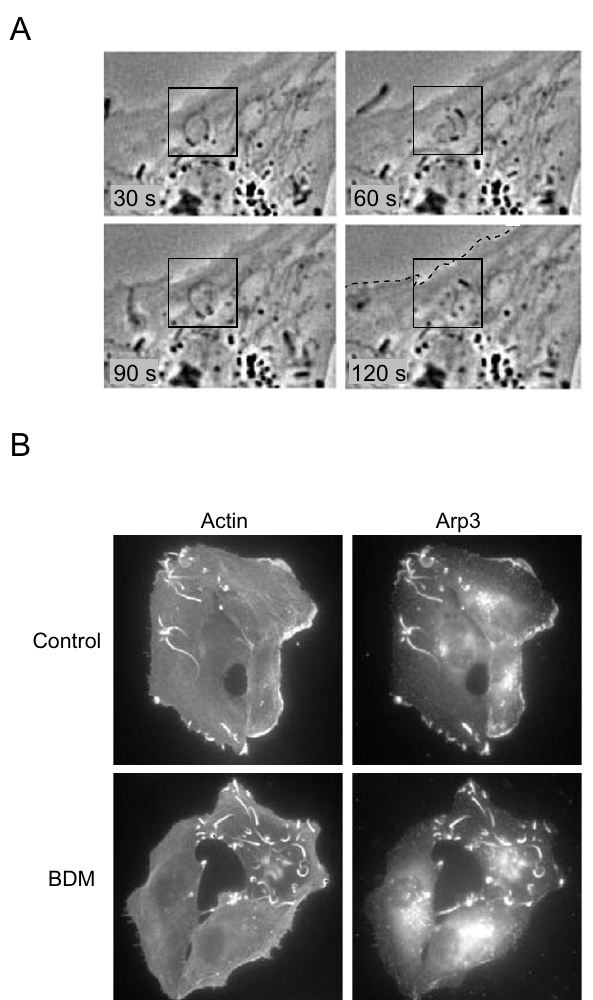
Movement of Listeria monocytogenes and Arp3 locali- zation in the actin comet tail is not disrupted with BDM. (A) A Listeria bacterium (boxed) continues to move with a phase dense actin tail after BDM addition at 0s. Inhibi- tion of cell ruffling can be seen at 120s, the outline of the cell boundary at 0s is marked by a dotted line. (B) Localization of Arp3 in Listeria comet tails shows no discernible difference between control and BDM treatment. Note the lack of local- ization at the leading edge of the BDM treated